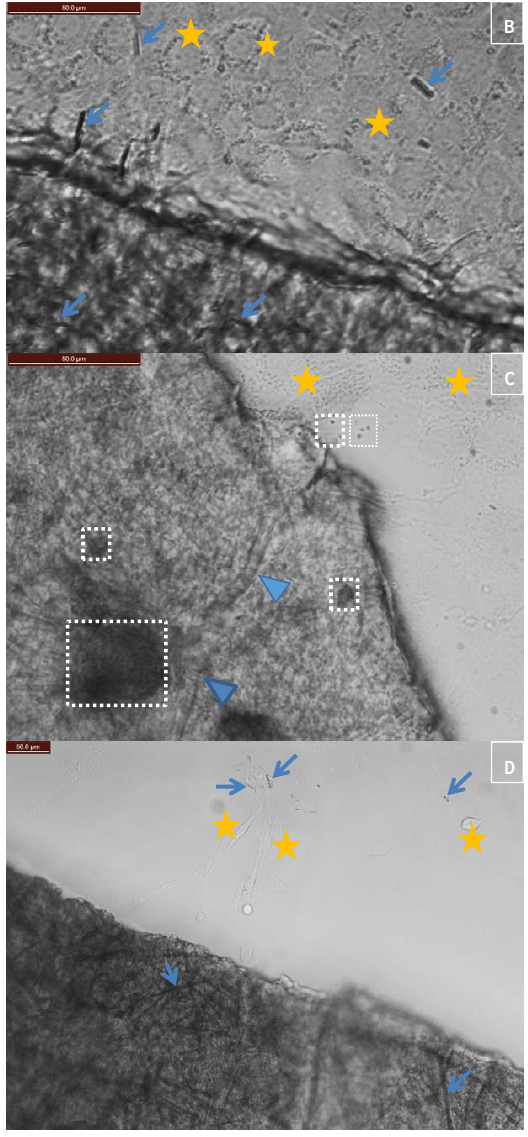
Figure 6. ( A ) Cellulose film testing with cells in defined microenvironments. Cellulose matrix materials alone were tested for compatibility with cell culture conditions. Bottom portion of the image shows the cellulose matrix and top portion shows glioma cells. Scale bar indicates 50 microns (upper left of figure). Blue arrowheads indicate cellulose fibers and stars indicate edges of glioma cells; ( B ) Cellulose films testing with cells in defined microenvironments. Cellulose-CuHARS biohybrids. Bottom portion shows the cellulose-CuHARS matrix and top portion shows glioma cells with some released CuHARS. To evaluate integration into the matrix of smaller size biohybrids, CuHARS were sonicated as previously described [12] before combining with cellulose. Scale bar indicates 50 microns (upper left of figure). Blue arrows indicate CuHARS and stars indicate edges of glioma cells; ( C ) Cellulose-CuONPs biohybrids. Left and lower portion shows the cellulose-CuONPs matrix and right and upper portion shows glioma cells with some released CuONPs aggregates. Scale bar indicates 50 microns (upper left of figure). Blue arrowheads indicate cellulose fibers, stars indicate edges of glioma cells, and white boxes indicate CuONPs aggregates of different sizes; ( D ) Cellulose-CuHARS-Fe 2 O 3 NPs biohybrids. Bottom portion shows the cellulose-CuHARS-Fe 2 O 3 NPs matrix and top portion shows glioma cells with some released CuHARS. Scale bar indicates 50 microns (upper left of figure). For these integrated hybrids, CuHARS were not sonicated before mixing with cellulose. Therefore, some very long CuHARS were successfully integrated into the cellulose matrix, as indicated. Blue arrows indicate CuHARS and stars indicate edges of glioma